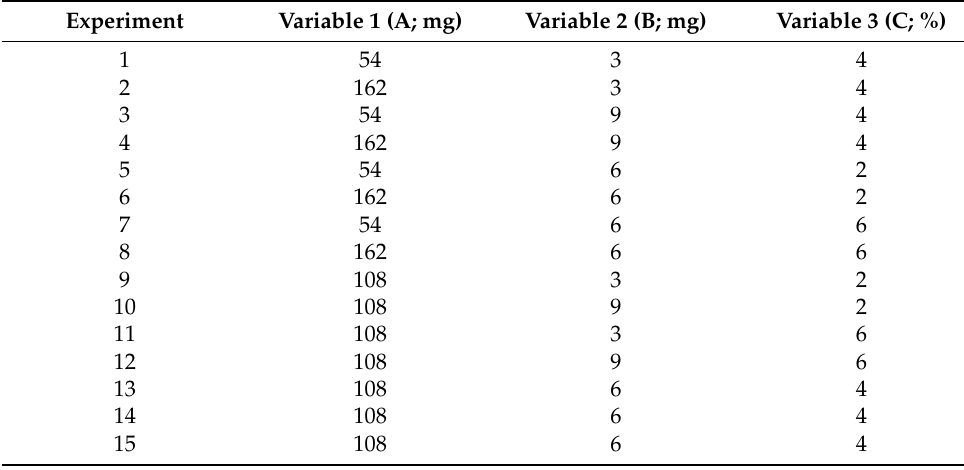
Table 2. Box–Behnken 3-level factorial design with the actual